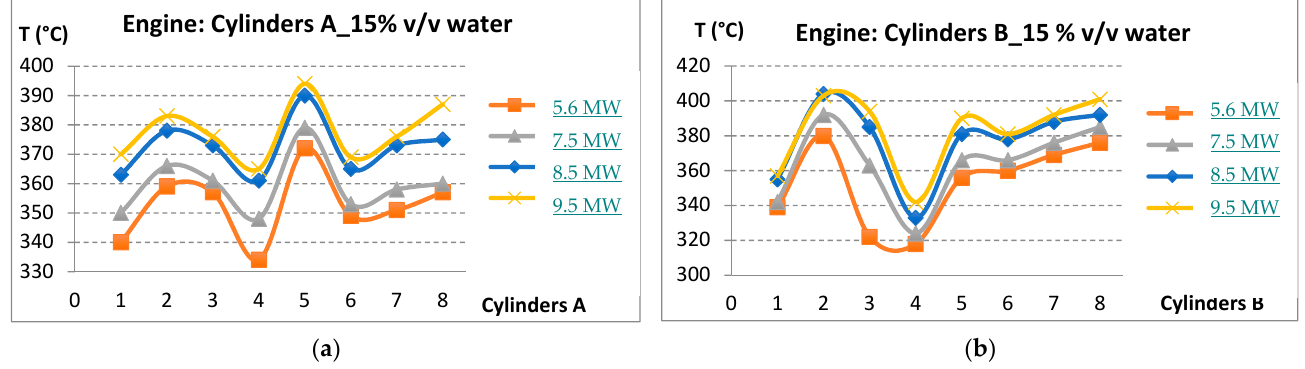
Figure 17. Variation in cylinders temperature in the rated operating regimes: ( a ) cylinders on side A; ( b ) cylinders on side B.